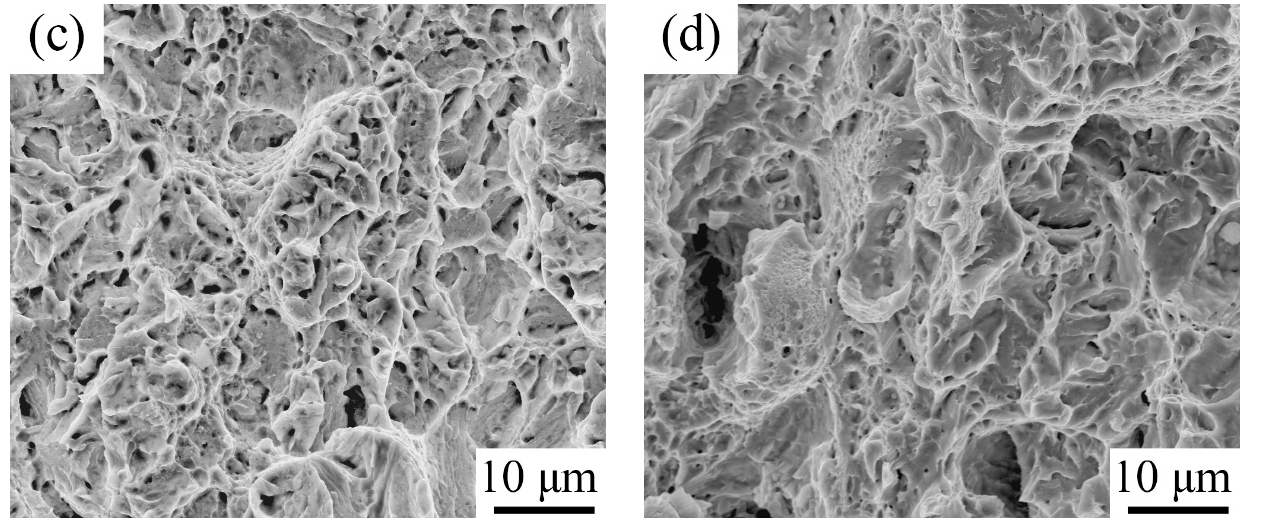
Figure 10. − 20 °C impact energy after being tempered at 200 °C: ( a ) impact of varying energy with Figure 10. − 20 ◦ C impact energy after being tempered at 200 ◦ C: ( a ) impact of varying energy with IA time; ( b – d ) are the fracture morphologies of IA-6 h, IA-12 h, and 50 h, respectively. IA time; ( b – d ) are the fracture morphologies of IA-6 h, IA-12 h, and 50 h,